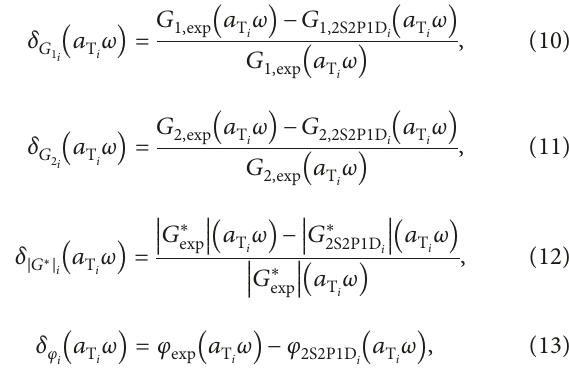
histograms of Figure 7. Error bars are plotted according to standard deviation